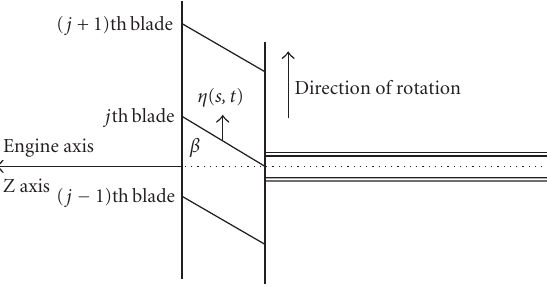
Figure 14: Up view of the bladed disk and the stagger angle β of the blades.